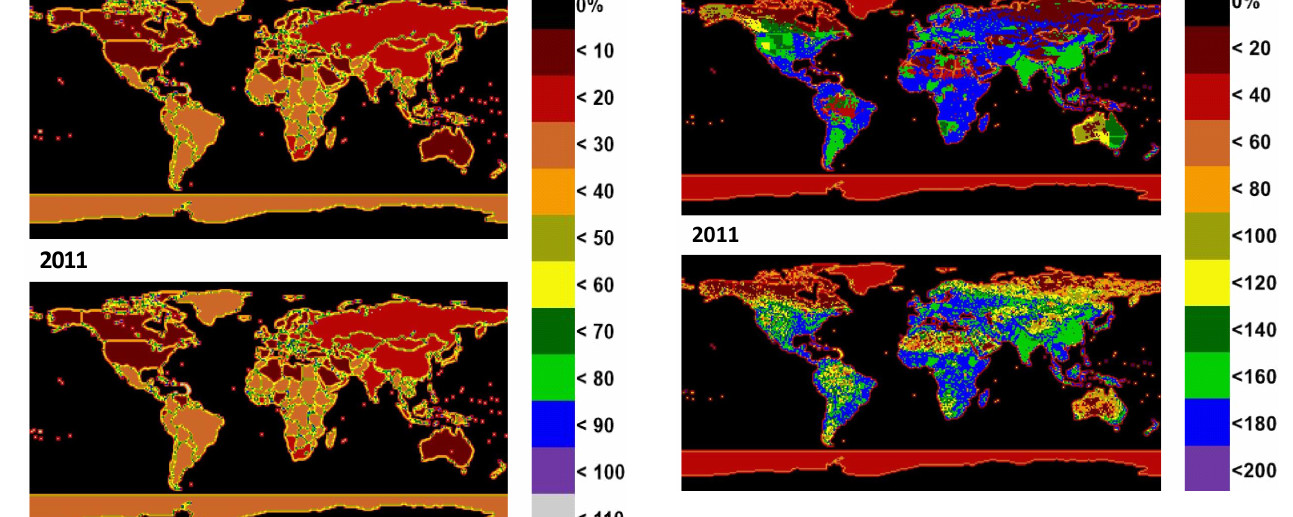
Figure 11. Three-component 2 σ